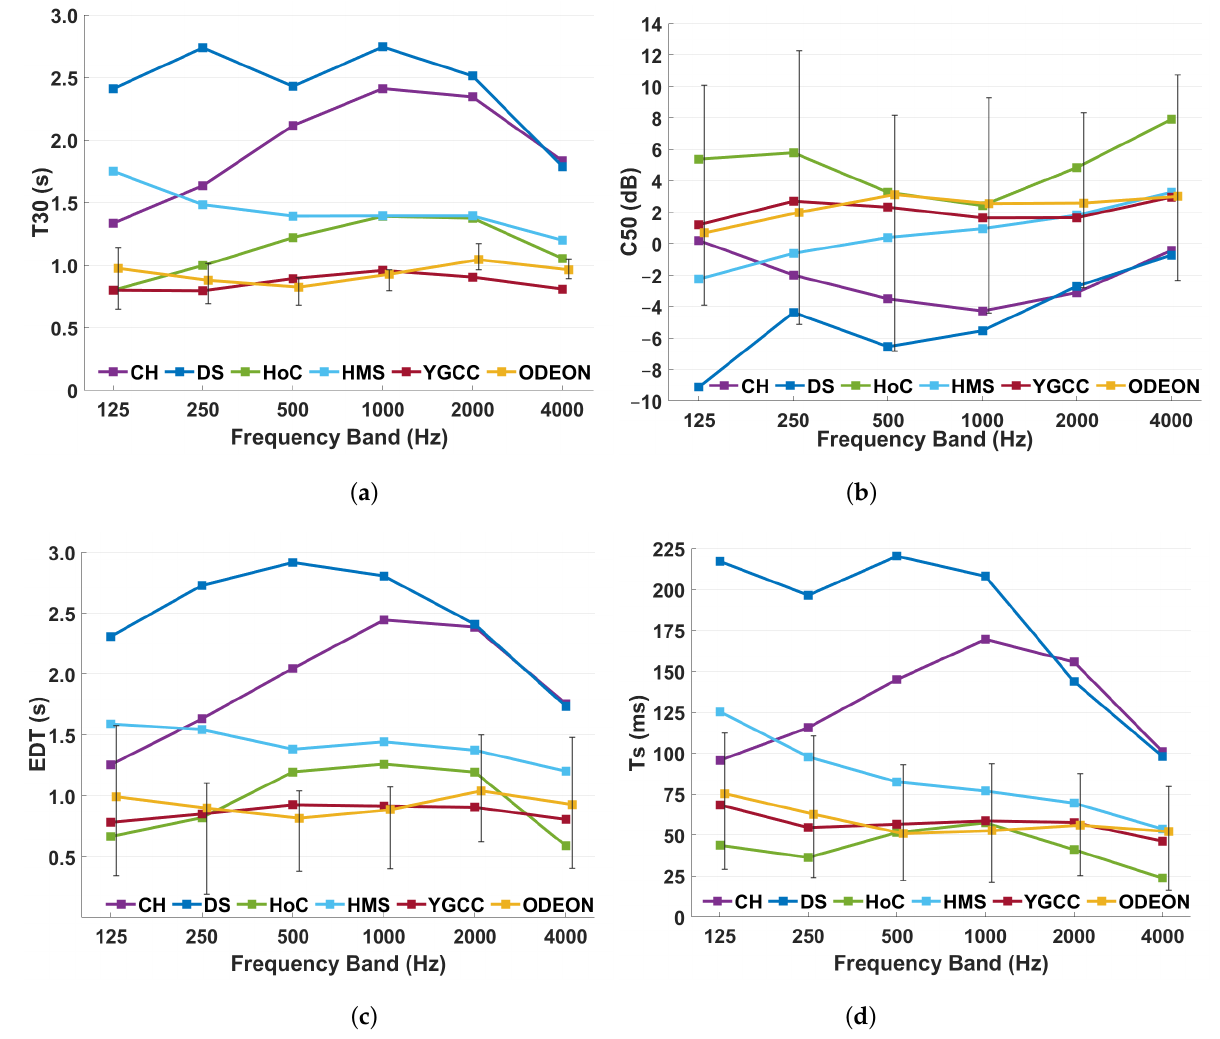
Figure 22. Average values of the five in situ measurements compared with the final model in ODEON: ( a ) T30, ( b ) C50, ( c ) EDT and ( d ) Ts. Error bars indicate the deviation of the values across the different measured positions of the ODEON